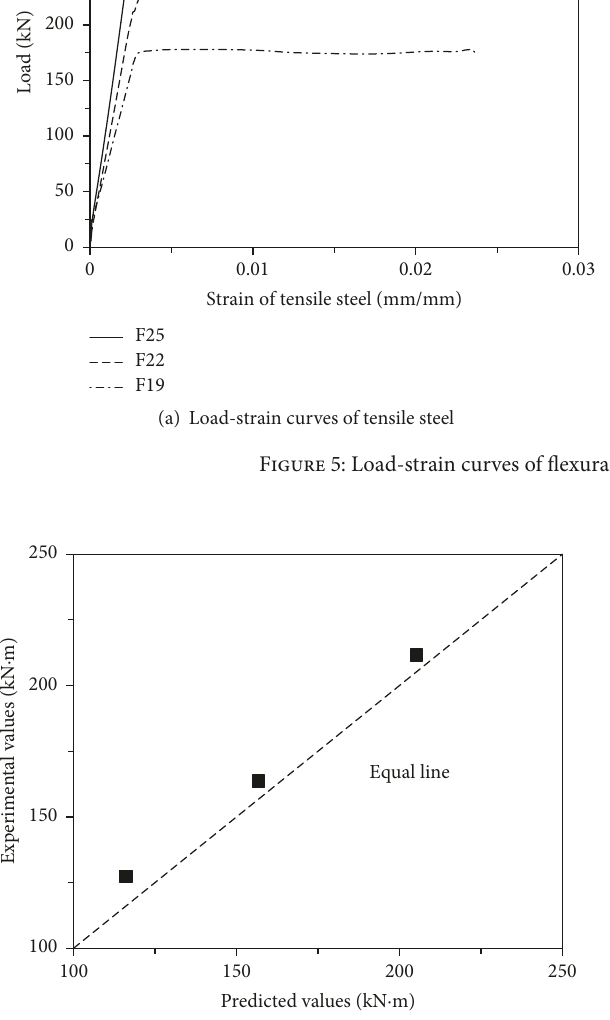
Figure 6: Comparison of experimental and predicted ultimate